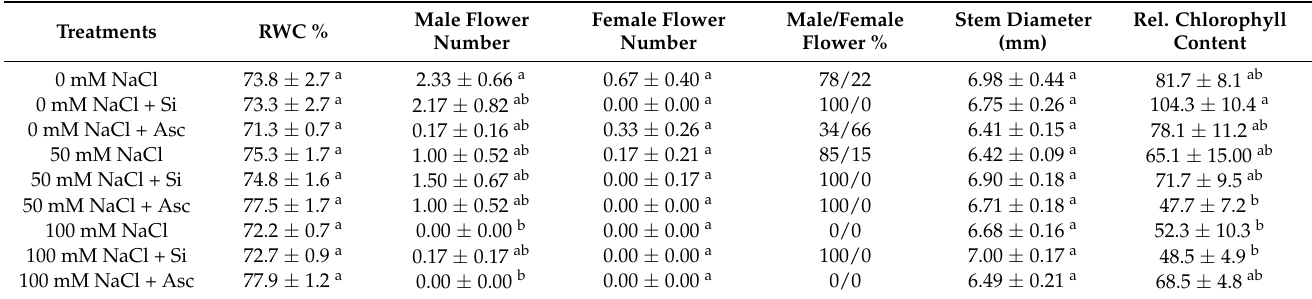
Table 1. Floral and physiological parameters of watermelon transplants irrigated with nutrient solution of different NaCl concentration and sprayed with two biostimulants. Within a column, average values (n = 5) followed by different letters are significantly different (a < 0.05). RWC: relative water content.